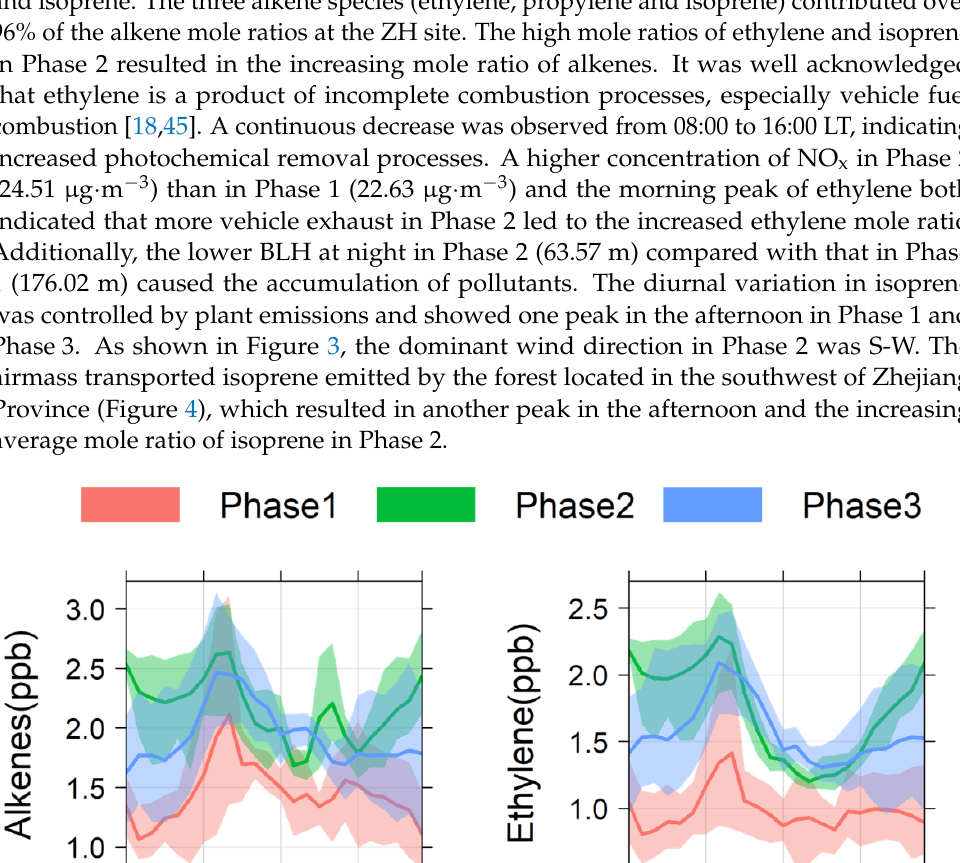
Figure 8. Diurnal variation in alkenes, ethylene, propylene and isoprene at the ZH site. The solid line represents the mean value, and the filled area indicates the 95% confidence intervals in the mean. 3.4. Source Apportionment of VOCs To further understand the VOC sources, five factors were resolved for VOC meas- urement during 23 August–15 September with PMF analysis. The number of effective samples were 336 and 96 at the ZH site, 307 and 195 at the DSL site and 299 and 188 at the YX site during the control and deregulation periods. These numbers met the condition that the span of effective samples used for PMF input data should be no less than 80 groups [46]. Because of the short data span, uncertainties regarding the PMF results were inevitable. The factor profiles of the three sites are shown in Figure S1. These factors were identified as factor 1, vehicle exhaust; factor 2, plants; factor 3, industry emissions; factor 4, fuel vaporization for the ZH and YX sites and fuel vaporization + incomplete combus- tion for the DSL site; factor 5, solvent usage. The high factor loadings of long chain alkanes, ethylene, acetylene and benzene were found in factor 1. The C 3 -C 6 alkanes usually were associated with emissions from imper- fect combustion vehicular emissions [4,40]. Cai et al. [24] reported that ethylene and pro- pylene were major species that were the product of internal combustion engines. Acety- lene was an incomplete combustion tracer, while benzene was also emitted with vehicular emissions [18]. Therefore, factor 1 was attributed to vehicle exhaust. Factor 2 exhibited a high composition of isoprene, which was mostly due to phyton- cide released from plants [47]. Thus, factor 2 was as attributed to plants.